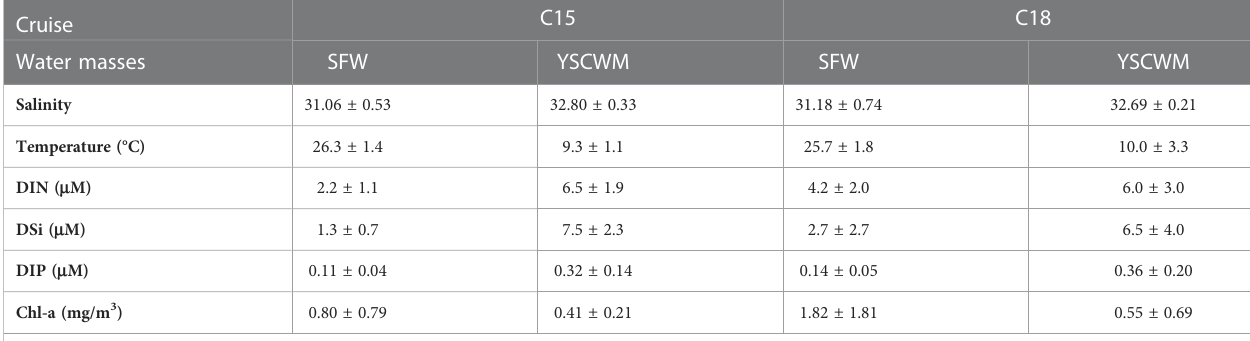
TABLE 1 Nutrient conditions and Chl-a concentrations of the three water masses during the two summer fi eld surveys in the Yellow Sea.